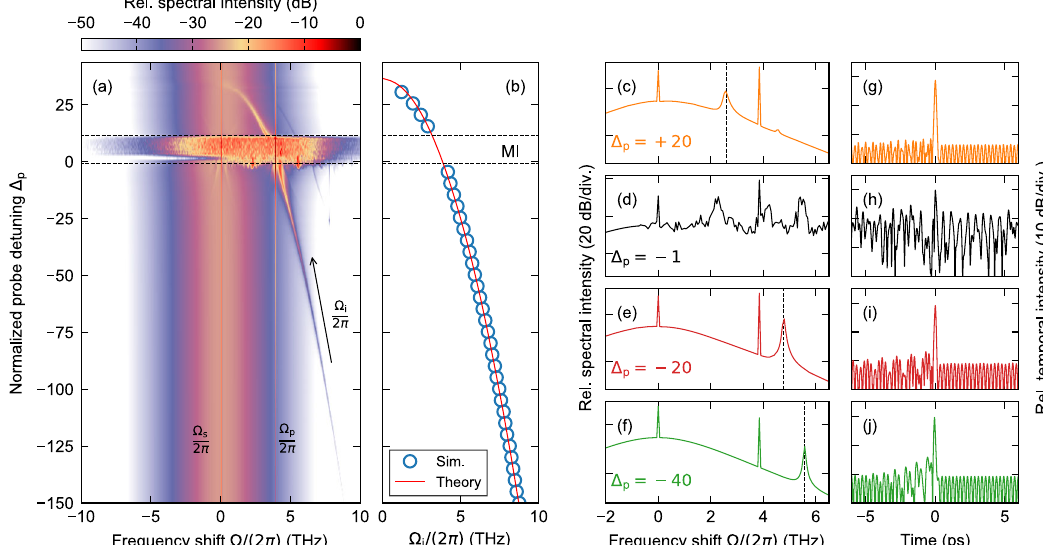
Fig. 2 Numerical simulation of soliton-linear wave interactions in a Kerr microresonator. a Pseudo-color plot shows the intracavity spectrum as a function of the probe detuning normalized to half the cavity linewidth, Δ p = δ p / α . The x -axis denotes the frequency offset from the soliton-generating pump, Ω = ω − ω s . Ω s , Ω p , and Ω i respectively denote angular frequency detunings of the soliton ( Ω s = 0), the probe, and the idler. b Circles show the peak frequency detuning of the idler comb as a function of the linear probe detuning Δ p as extracted from the simulation data in ( a ). Solid red curve in ( b ) shows the phasematched frequency predicted by Eq. (5). Dashed horizontal lines in ( a ), ( b ) delineate the region within which the probe undergoes modulational instability and prohibits the soliton-linear wave interaction. c – f show individual spectra from ( a ) at selected probe detunings as indicated, with dashed vertical lines indicating the phasematched idler frequencies predicted by Eq. (5). g – j show the temporal intensity of the intracavity fi elds corresponding to the spectra shown in ( c – f ). The simulation results were obtained using the Lugiato-Lefever equation as described in Methods, with parameters similar to the experiments that will follow: F ¼ 3 : 1 ´ 10 4 , γ = 1.4 × 10 − 3 W − 1 m − 1 , β 2 = − 3.2 × 10 − 27 s 2 m − 1 , P in,i = ∣ E in,i ∣ 2 = 80 mW, with i = (s, p), and θ = 1 × 10 − 4